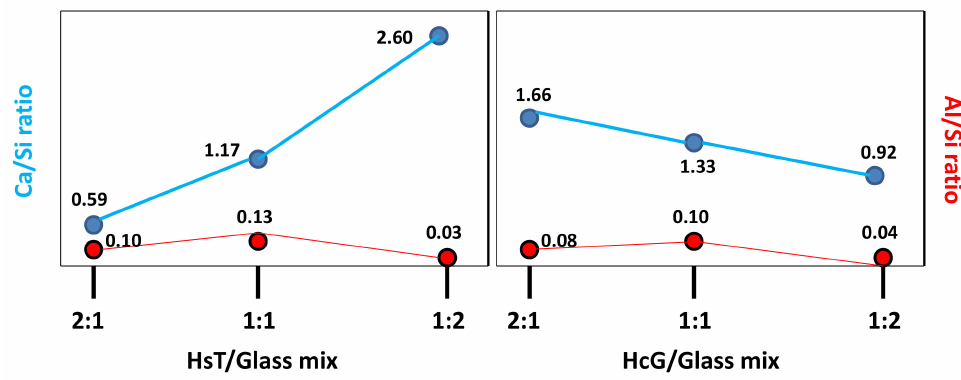
Figure 10. Variation of Ca/Si and Al/Si ratios as a function of the silicon content.